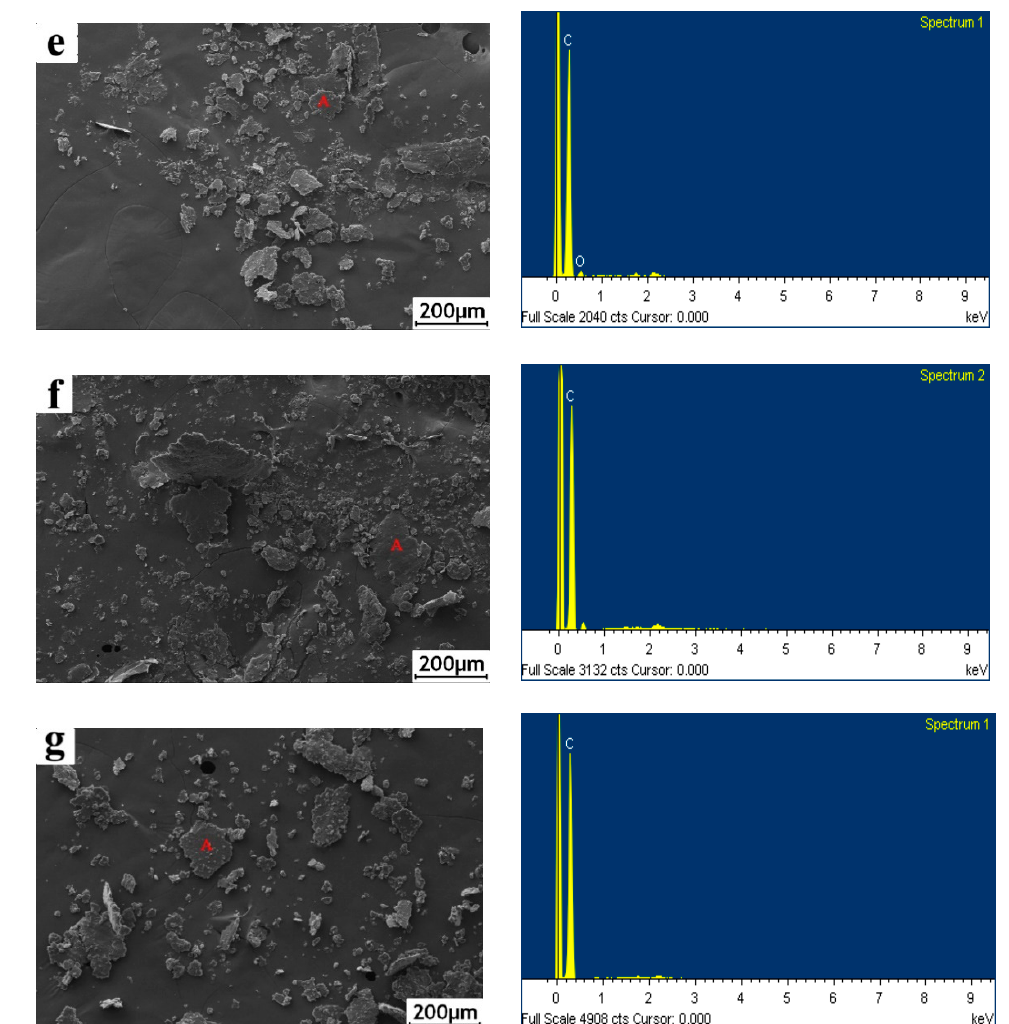
Figure 7. Morphology of the wear debris and EDS: ( a ) Mg, ( b ) micro-arc oxidation, A is the debris after the wear of MAO coating, which is powdered MgO. B is the massive peeling debris, which is produced by the magnesium matrix under the ceramic coating, ( c ) 20 wt%, ( d ) 40 wt%, ( e ) 60 wt%, ( f ) 80 wt%, and ( g ) 100 wt%.